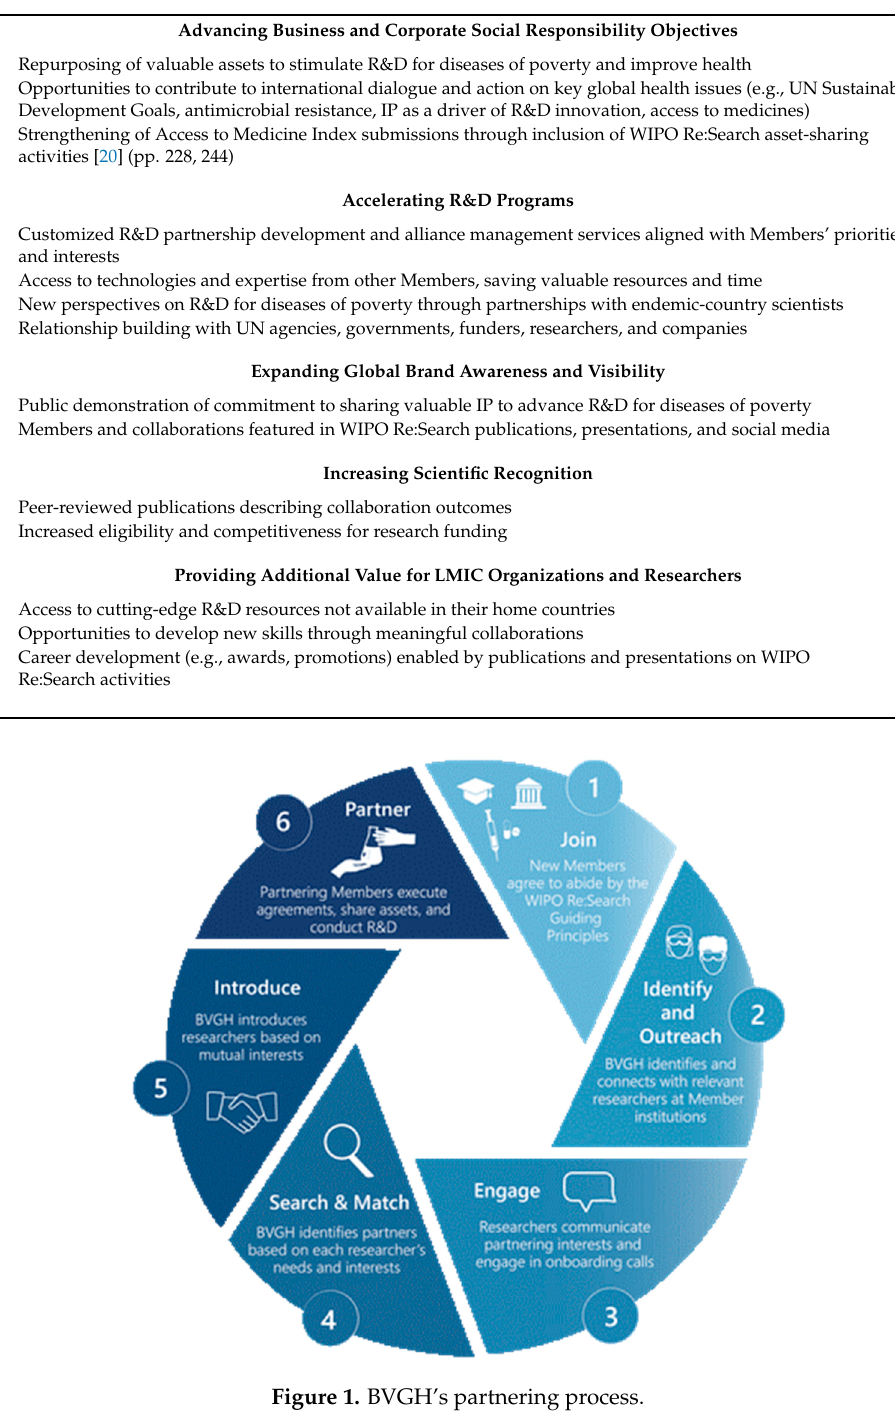
Table 2. WIPO Re:Search engagement delivers significant value to companies, research institutions, and scientists interested in research and product development for diseases of poverty.